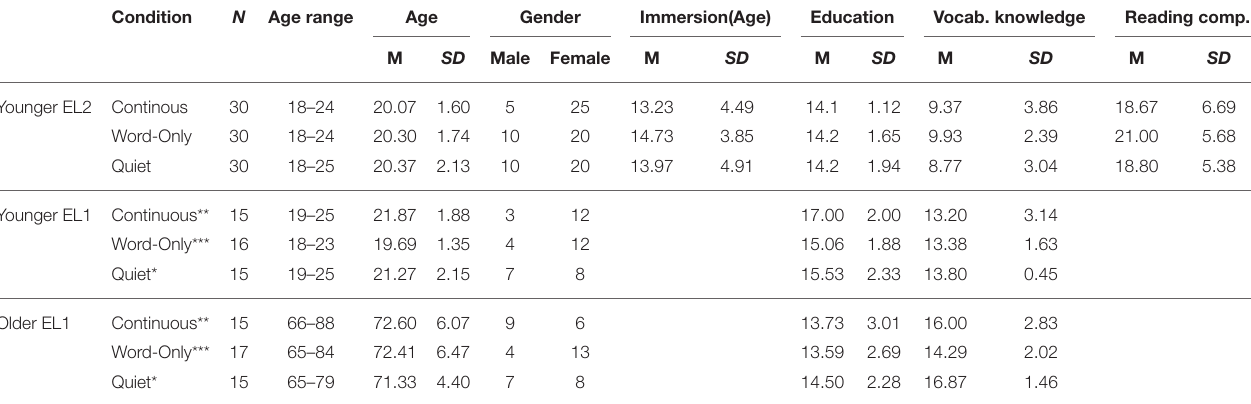
TABLE 1 | Participant parameters for the young EL2 and EL1 listeners under the three conditions tested along with those of the older EL1 listeners.